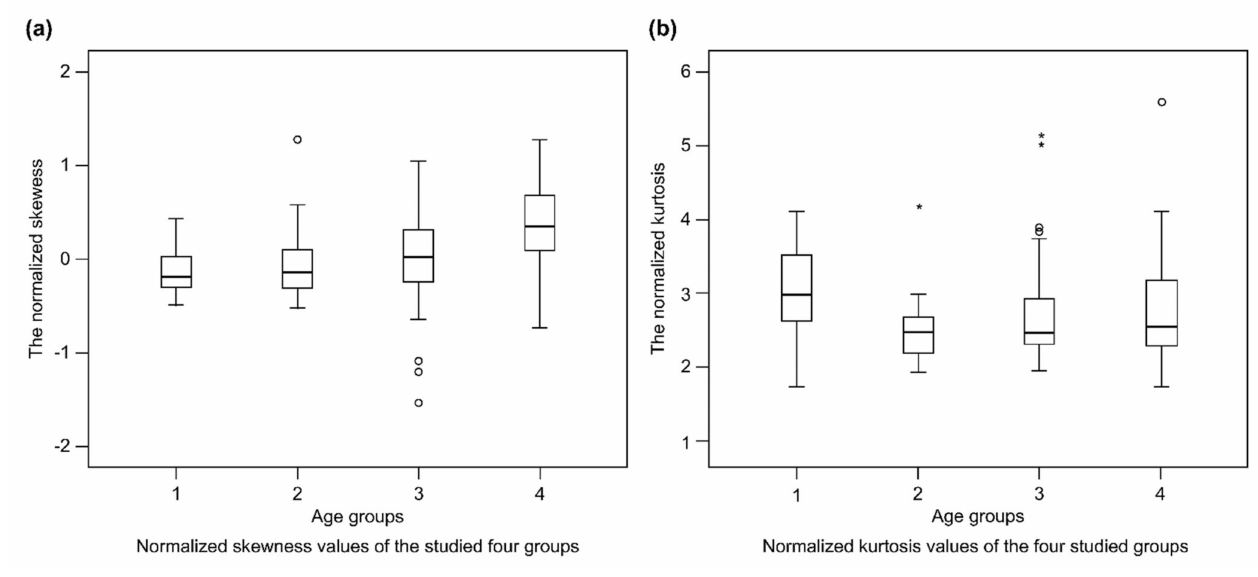
Figure 3. Distributions of higher-order statistical